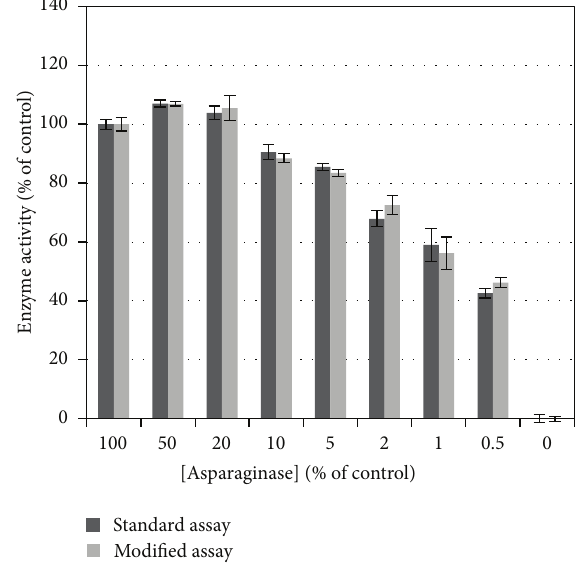
Figure 4: Loss of asparaginase enzyme activity. Asparaginase dilu- tion has a significant effect on enzyme activity ( 𝑃 < 0.0001 ); effects of assay types (standard commercial versus modified) are not signif- icant ( 𝑃 = 0.1059 ). The modified assay demonstrates loss of enzyme activity similar to that seen with the standard commercial assay.